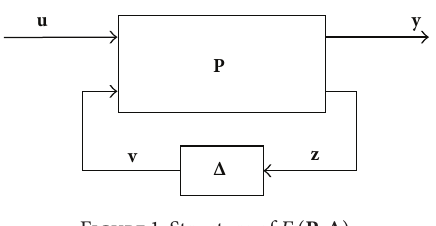
Figure 1: Structure of 𝐹 𝑙 ( P , Δ ) . Figure 2: MAW structural model.